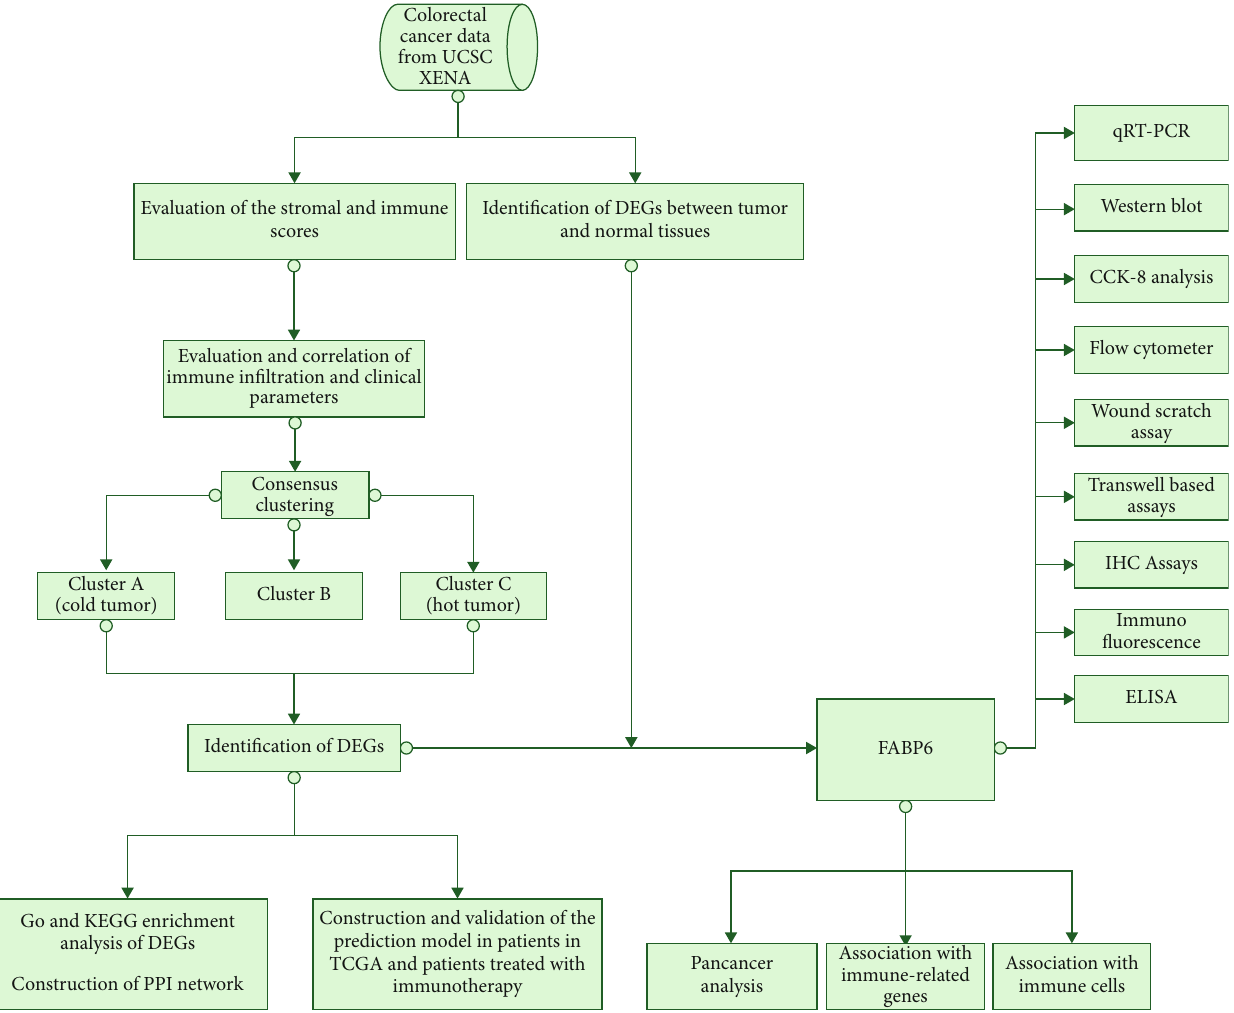
Figure 1: Flowchart of this